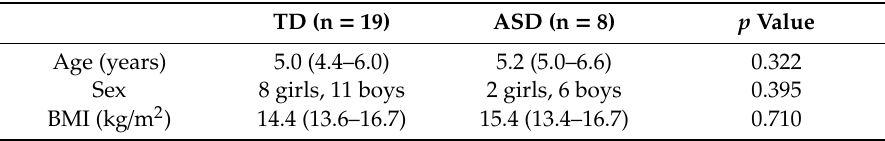
Table 1. Median and interquartile ranges of demographic characteristics of the subjects.